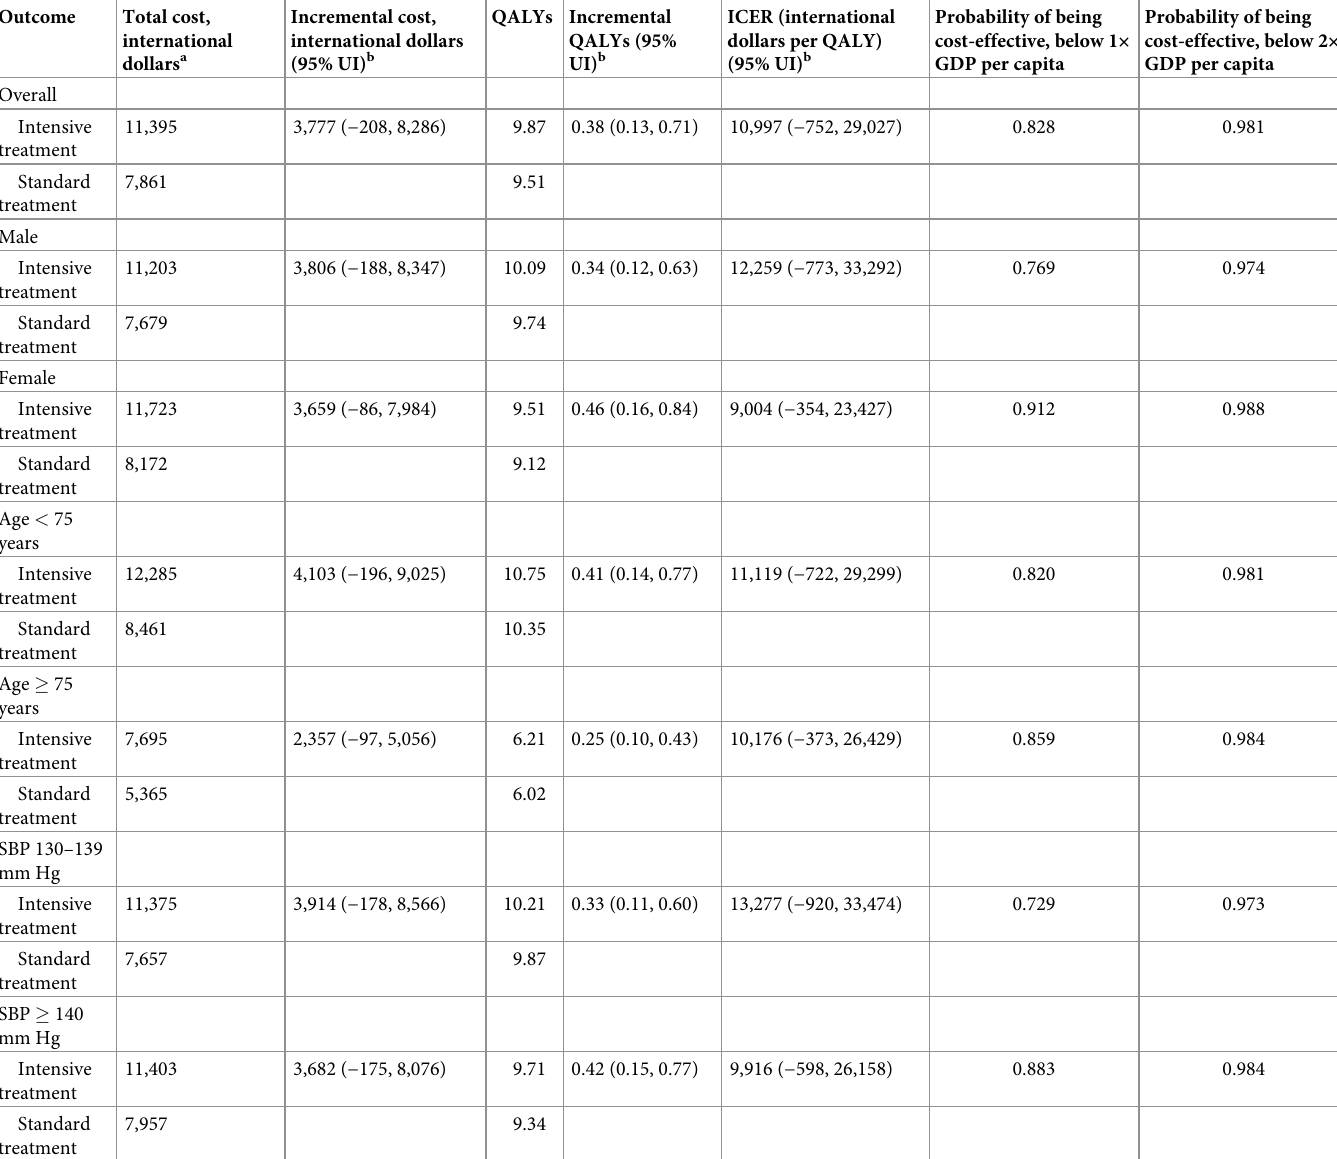
Table 1. Lifetime costs, QALYs, and ICER values for intensive versus standard blood pressure control